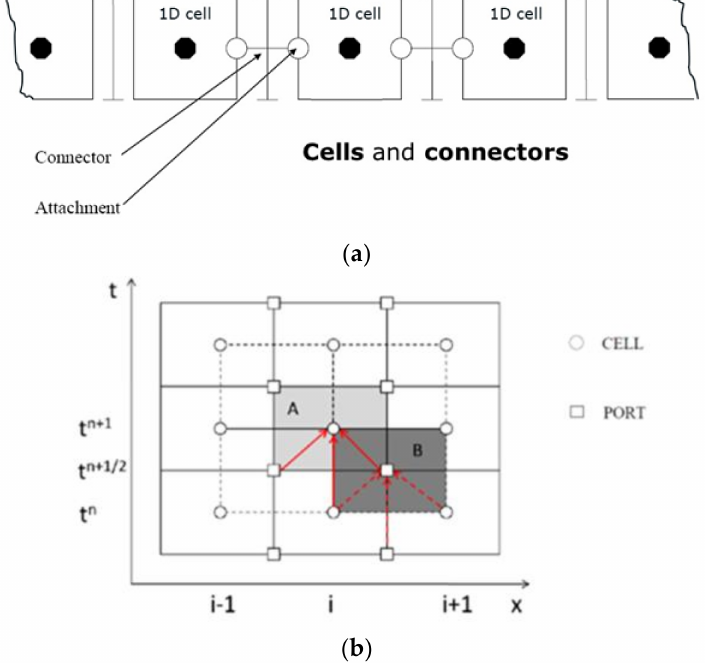
Figure 1. ( a ) One-dimensional 1Dcell approach, cells and connectors; ( b ) time marching procedure adopted for the solution of the governing equation in the 1Dcell method: (A) represents the cell control volume and (B) represents the port control